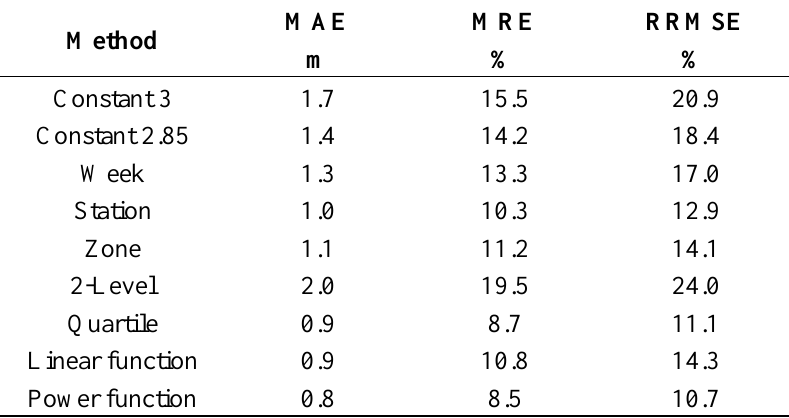
Table 1. The error indicators for the tested